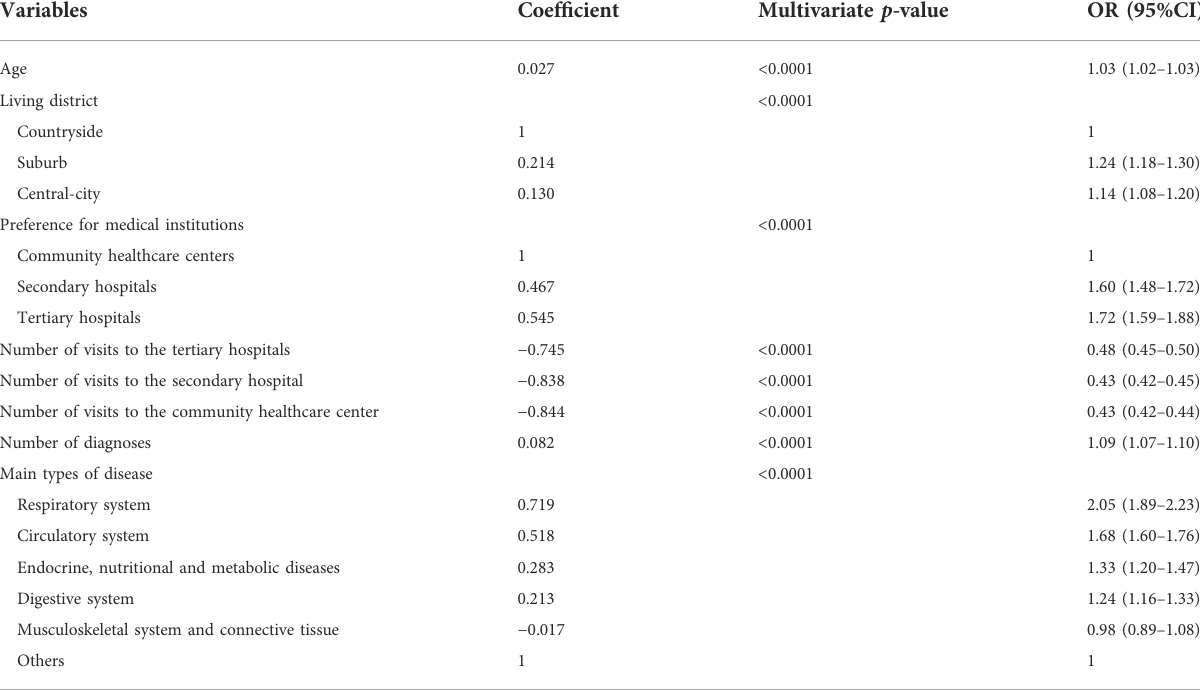
TABLE 2 Logistic regression analysis of risk predictors for polypharmacy in the elderly based on training